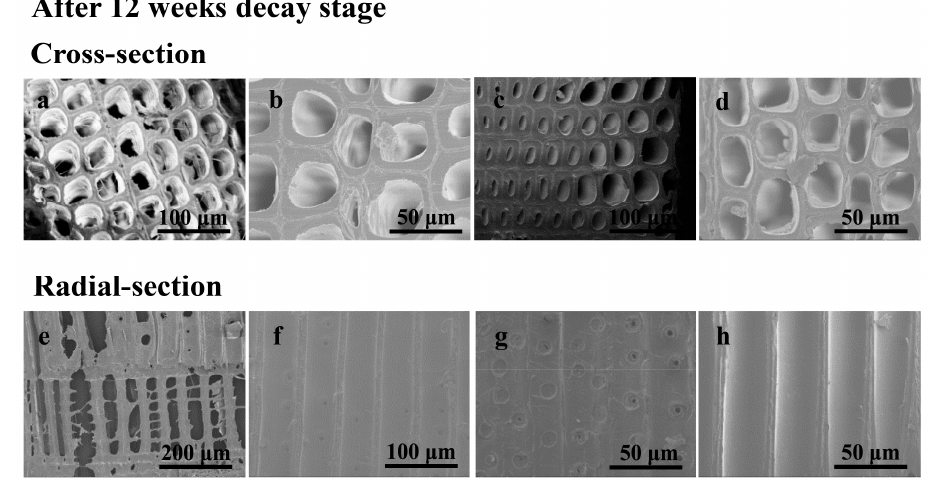
Figure 4. SEM photographs of wood samples after 12 weeks decay stage. Cross-section: ( a ), control sample, ( b ), sample treated with P 1 , ( c ), sample treated with P 2 , ( d ), sample treated with P 3; Radial-section: ( e ), control sample, ( f ), sample treated with P 1 , ( g ), sample treated with P 2 , ( h ), sample treated with P 3 .